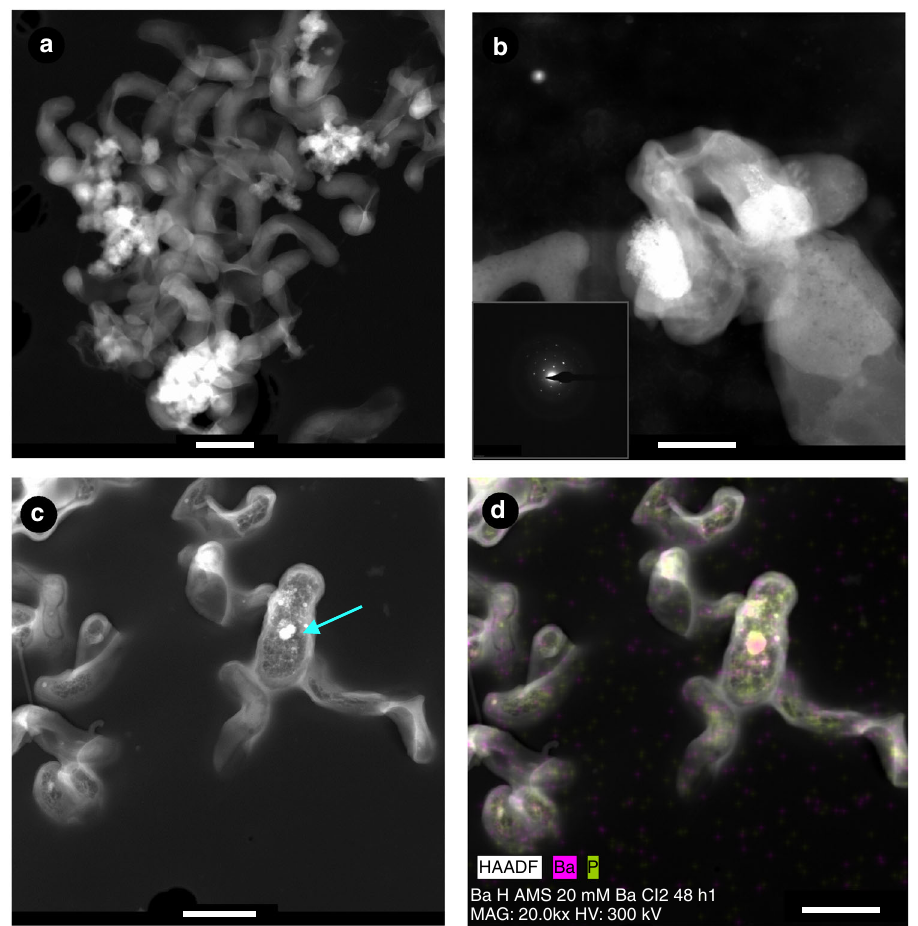
Fig. 4 HRTEM images of bacterial bio fi lms. a HAADF images showing bacterial bio fi lms of I . loihiensis MAH1. b High-magni fi cation photograph of precipitates formed after 48 h of incubation in SSW2 medium. A selected area electron diffraction image is included in photograph b to show the crystalline nature of the precipitates (the composition is shown in Supplementary Fig. 2). c Intracellular grains enriched in P (indicated with an arrow). d Corresponding EDX map showing the Ba and P distribution (spectrum is provided in Supplementary Fig. 3). Scale bar represents: a 500 nm, b 200